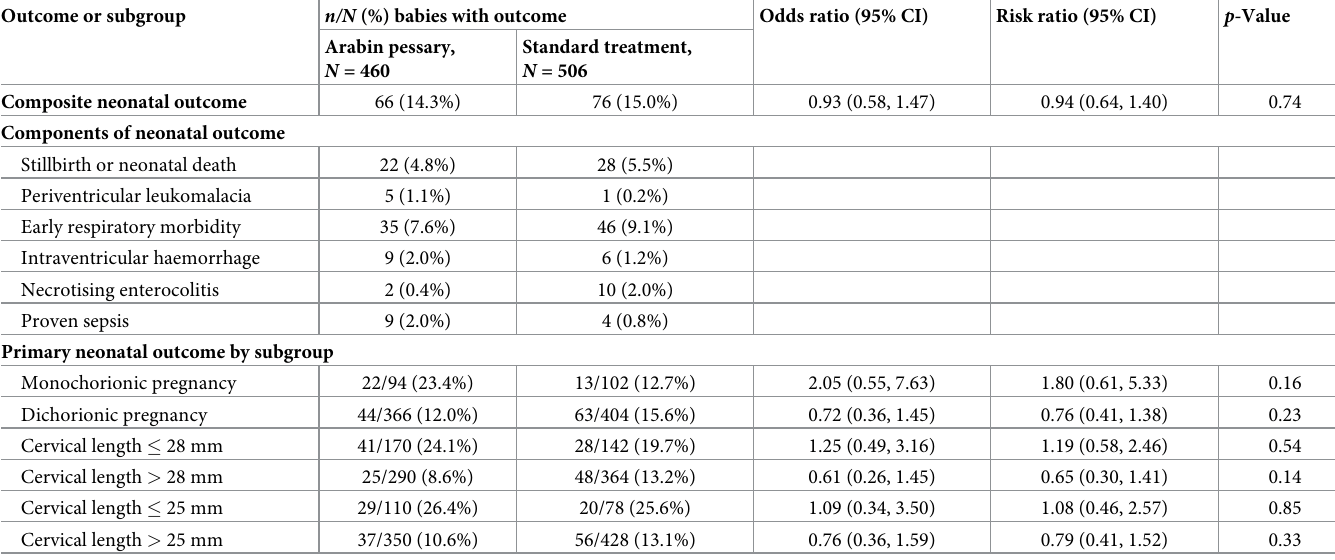
Table 7. Primary composite neonatal outcome, components and key subgroup analyses–per protocol.